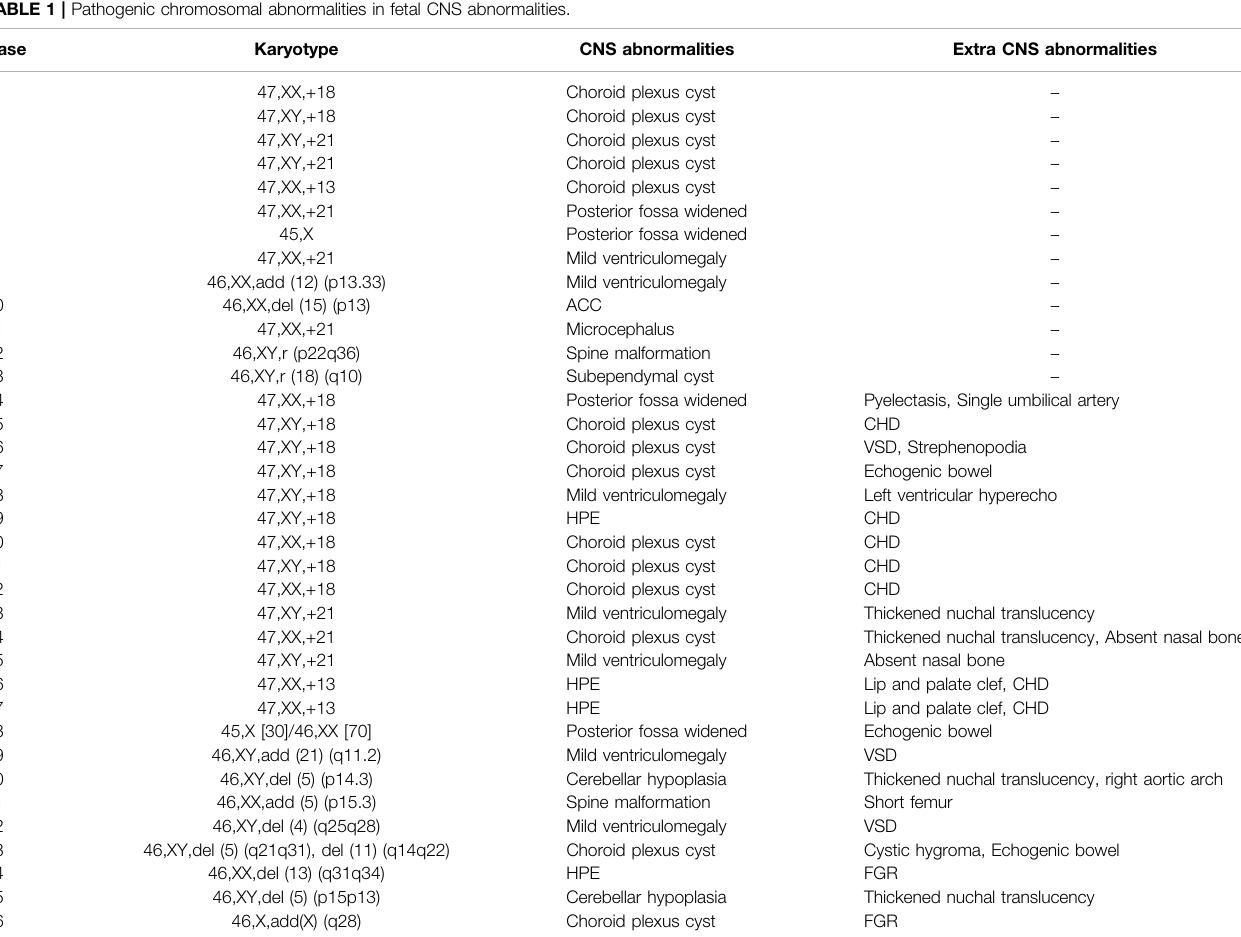
TABLE 1 | Pathogenic chromosomal abnormalities in fetal CNS